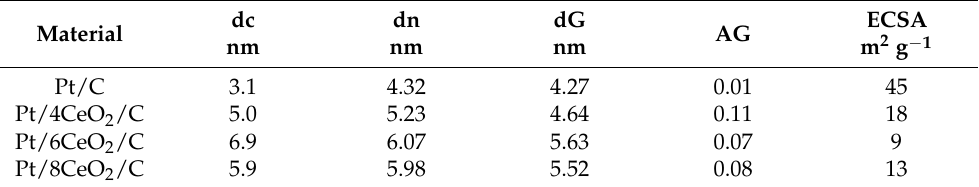
Figure 2. XRD patterns of Pt/C and Pt/CeO 2 /C catalysts and CeO 2 alone. Table 2. Crystallite size (dc) by XRD, and number average particle size (dn), Gaussian average particle size (dG) and distribution asymmetry index (AG) by TEM and roughness factor (RF) by CV (H 2 ) of Pt/CeO 2 /C and Pt/C